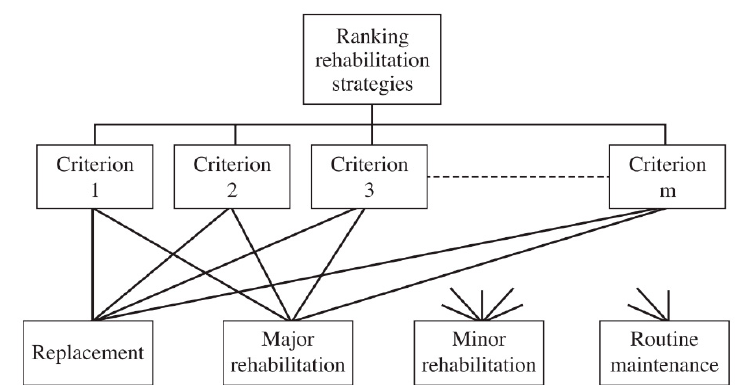
Figure 12. Multicriteria selections of maintenance actions for bridge decks [54].